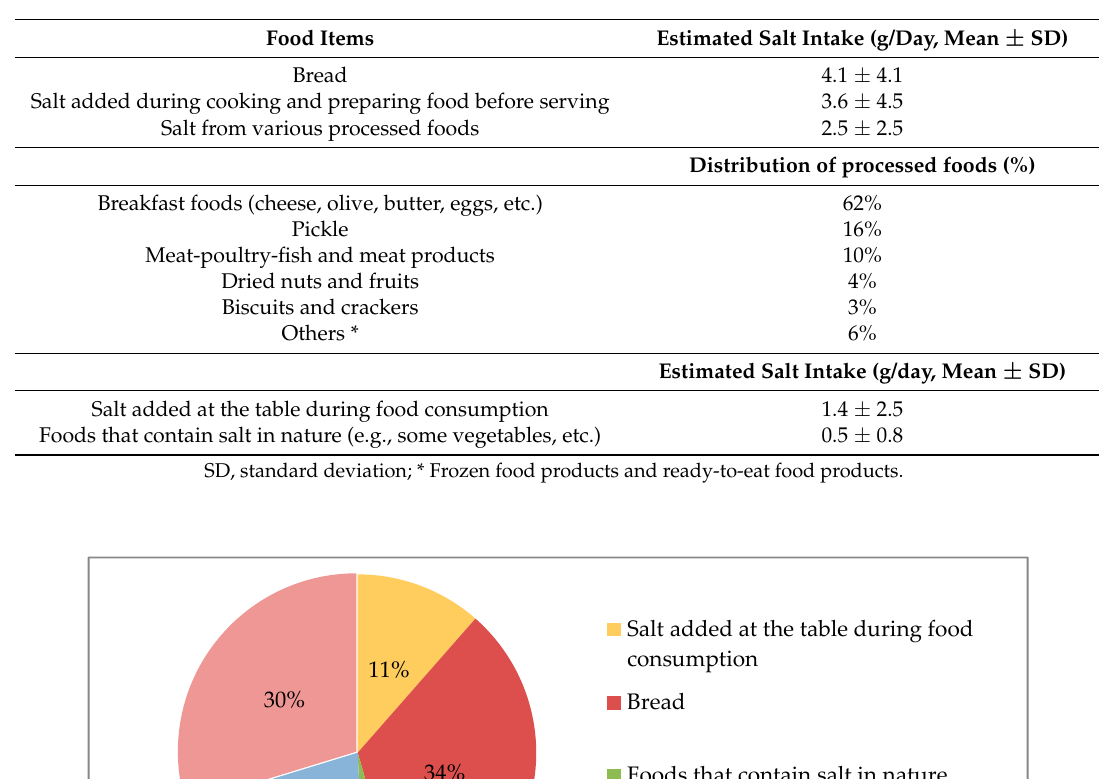
Table 3. Estimated dietary salt intake (g/day) and distribution of major food sources of salt.